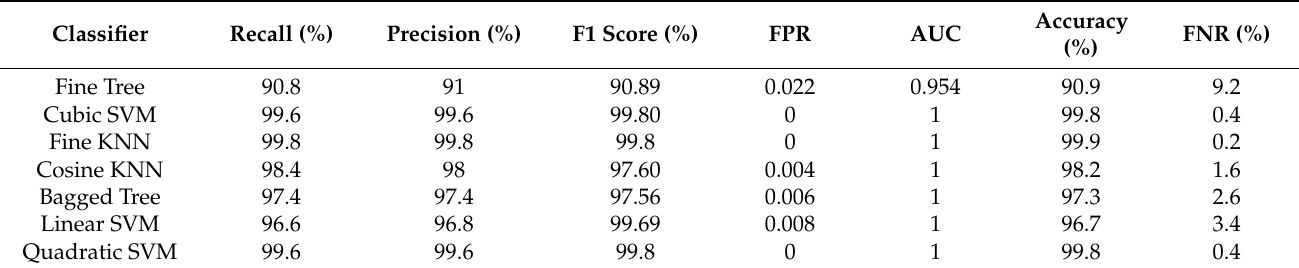
Table 5. Classification results using GA for Alexnet model features.